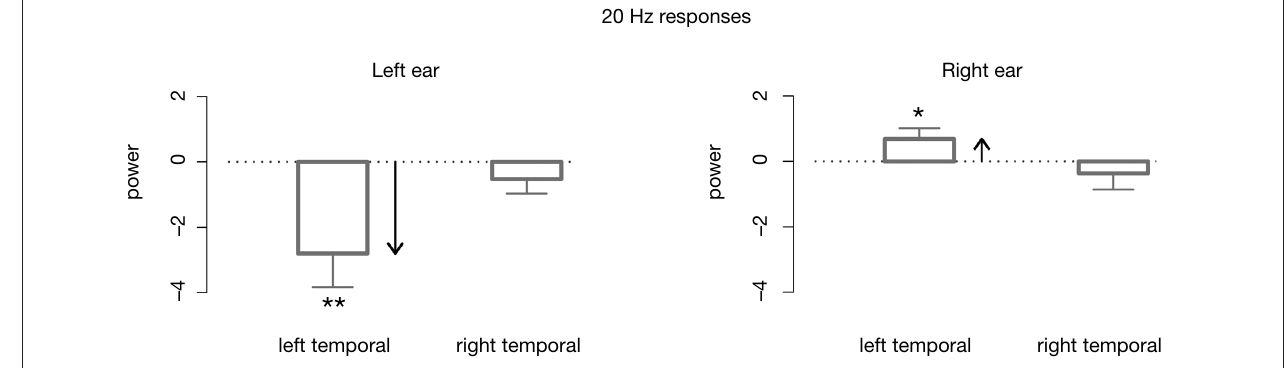
FIGURE 4 | Differences in mean power values between the attended and ignored 20 Hz aSSR (attend–ignore). Activations in the left temporal cortex are signifi cantly modulated by attention: following a right cue the steady-state